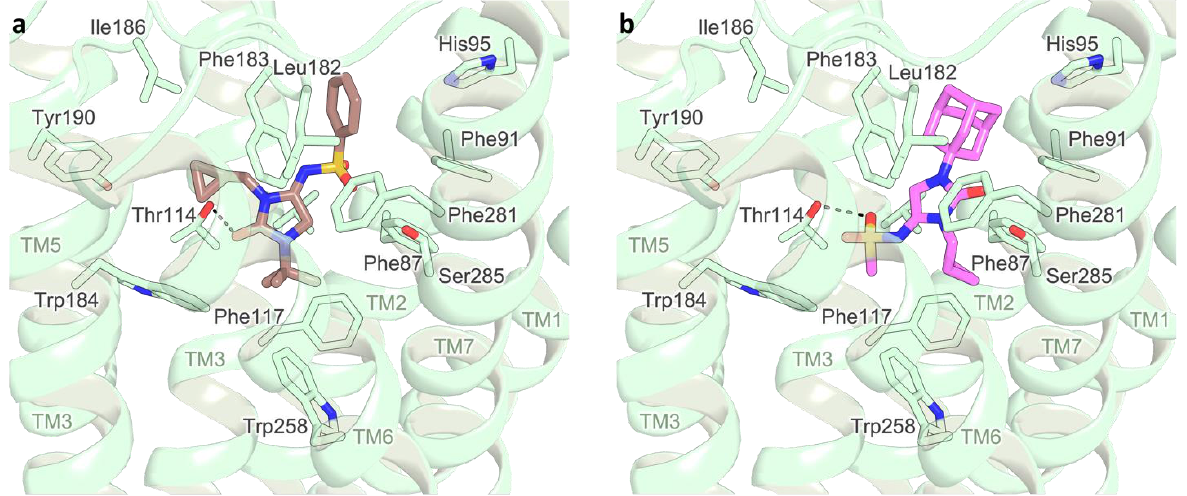
Figure 5. Docking poses of compounds 10b (brown, ( a )) and 12a (pink, ( b )) in the agonist conformation of the hCB2R receptor (PDB ID: 6KPC, light green cartoon). Residues lining the binding site are represented as capped sticks and labeled; transmembrane helices are numbered as TM1-7. Hydrogen bonds are represented as black dashed lines.